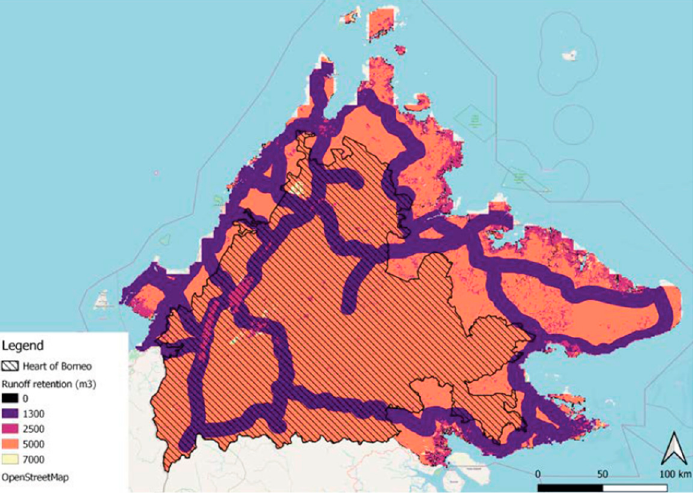
Figure 1. Runoff retention (m3)—current road scenario with deforestation [67].